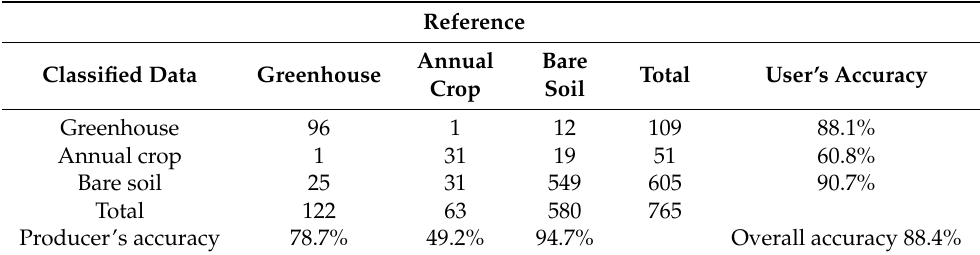
Table 2. Confusion matrix for the random point